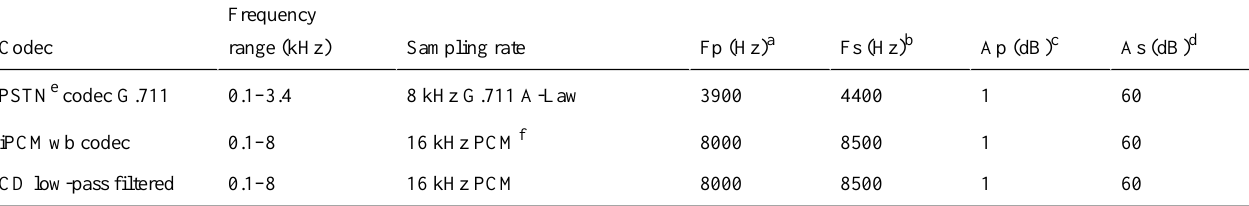
Table 2. Frequency and filter characteristics for each audio quality